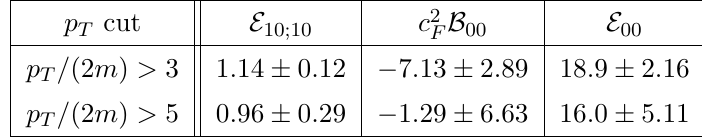
B 00 , and E 00 in units of GeV 2 for p T cuts F